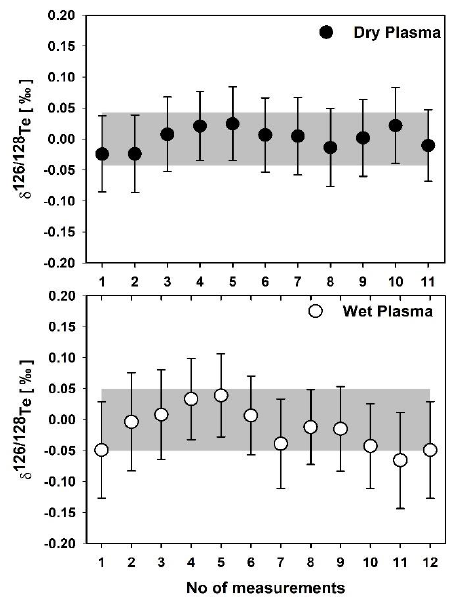
Figure 2. Reproducibility of Te isotope ratios analyses for the Kanto standard in wet and dry plasma conditions. The error bars show two standard deviations (2SD) from 10 block measurements in one run, representing the external reproducibility of the wet and dry plasma modes of the standard. Shaded zones depict 2SD of all standard runs for wet and dry plasma, respectively. Measurements were performed from October 2019 to January 2020 (seven analytical sessions for each plasma